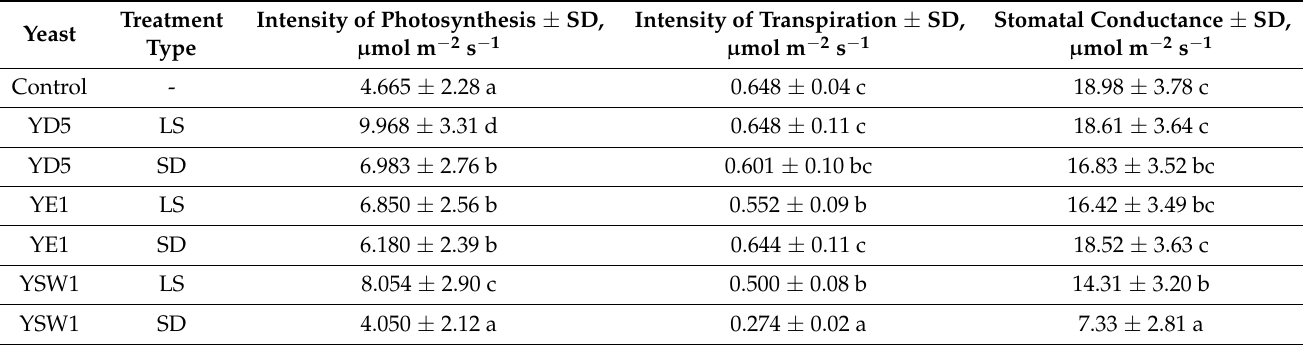
Table 7. Photosynthesis and transpiration rate in experimental tobacco plants treated by soil drench (SD) and leaf spraying (LS) at 14 days after first treatment.